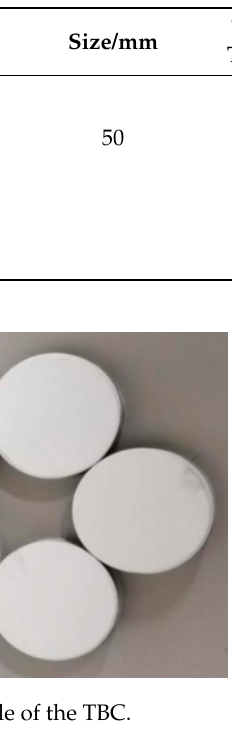
Table 2. Sample parameters.